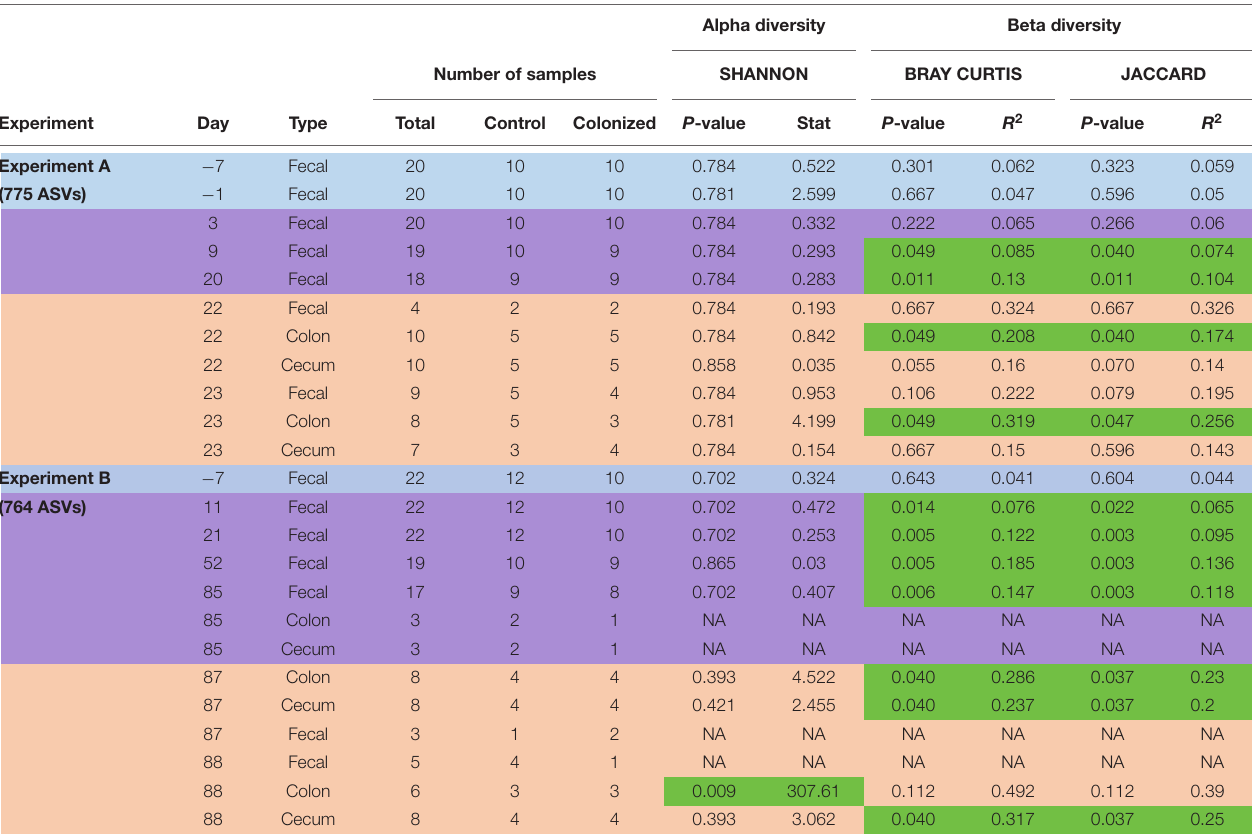
TABLE 2 | Summary of number of ASVs and samples used for analyses and results of alpha and beta diversity for both experiments (long-term and short-term colonization), from all days and sample’s